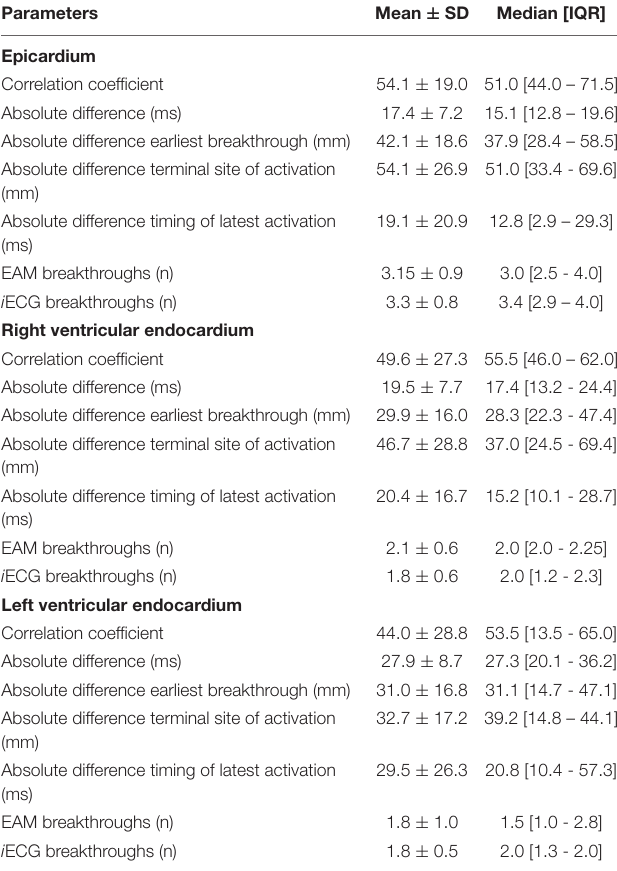
TABLE 1 | Comparison between i ECG and